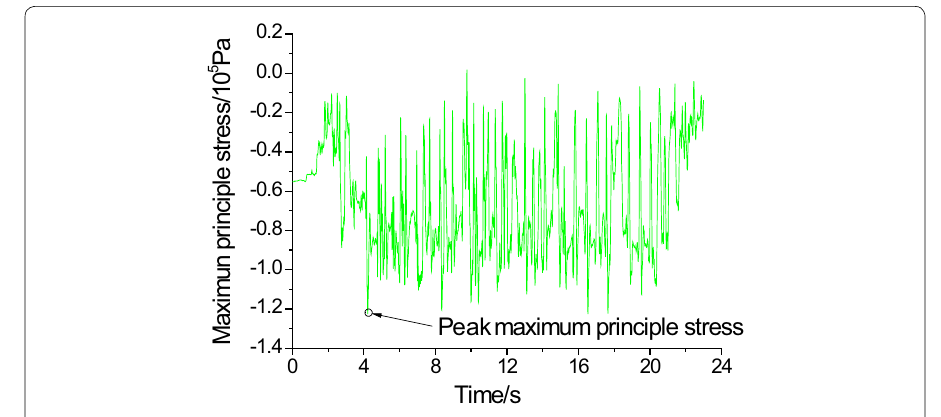
Fig. 9 Maximum principle stress time-history of zone ID